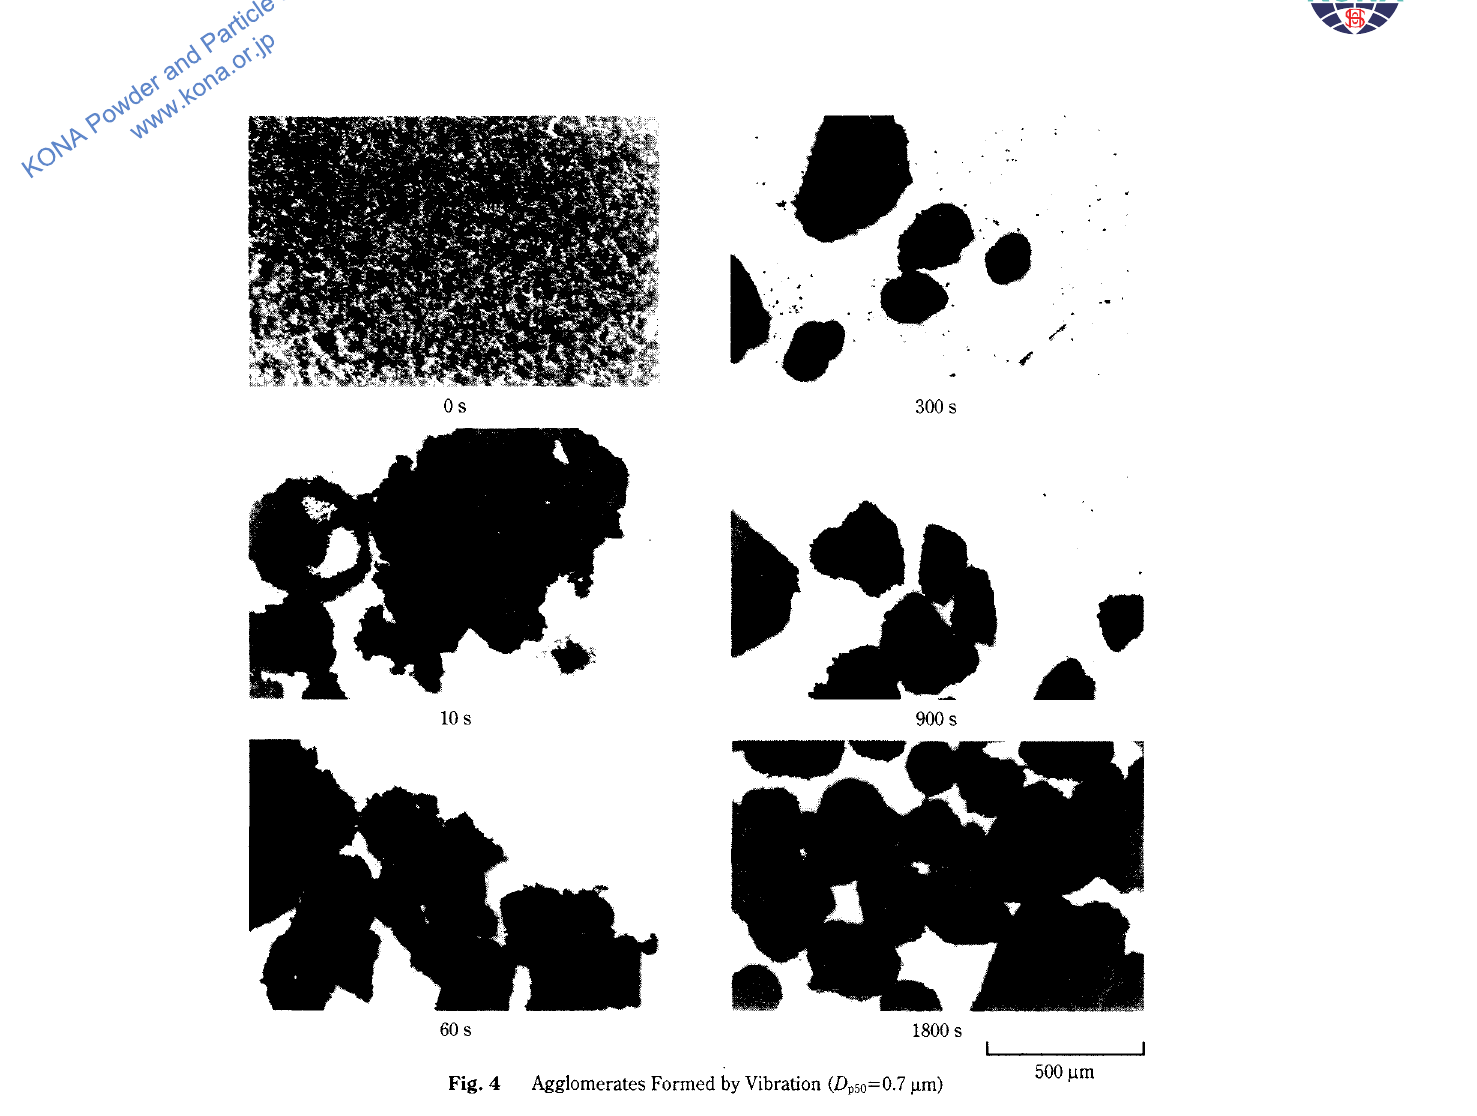
Agglomerates Formed by Vibration (Dp 50 =0.7 ~-tm) 500~-tm